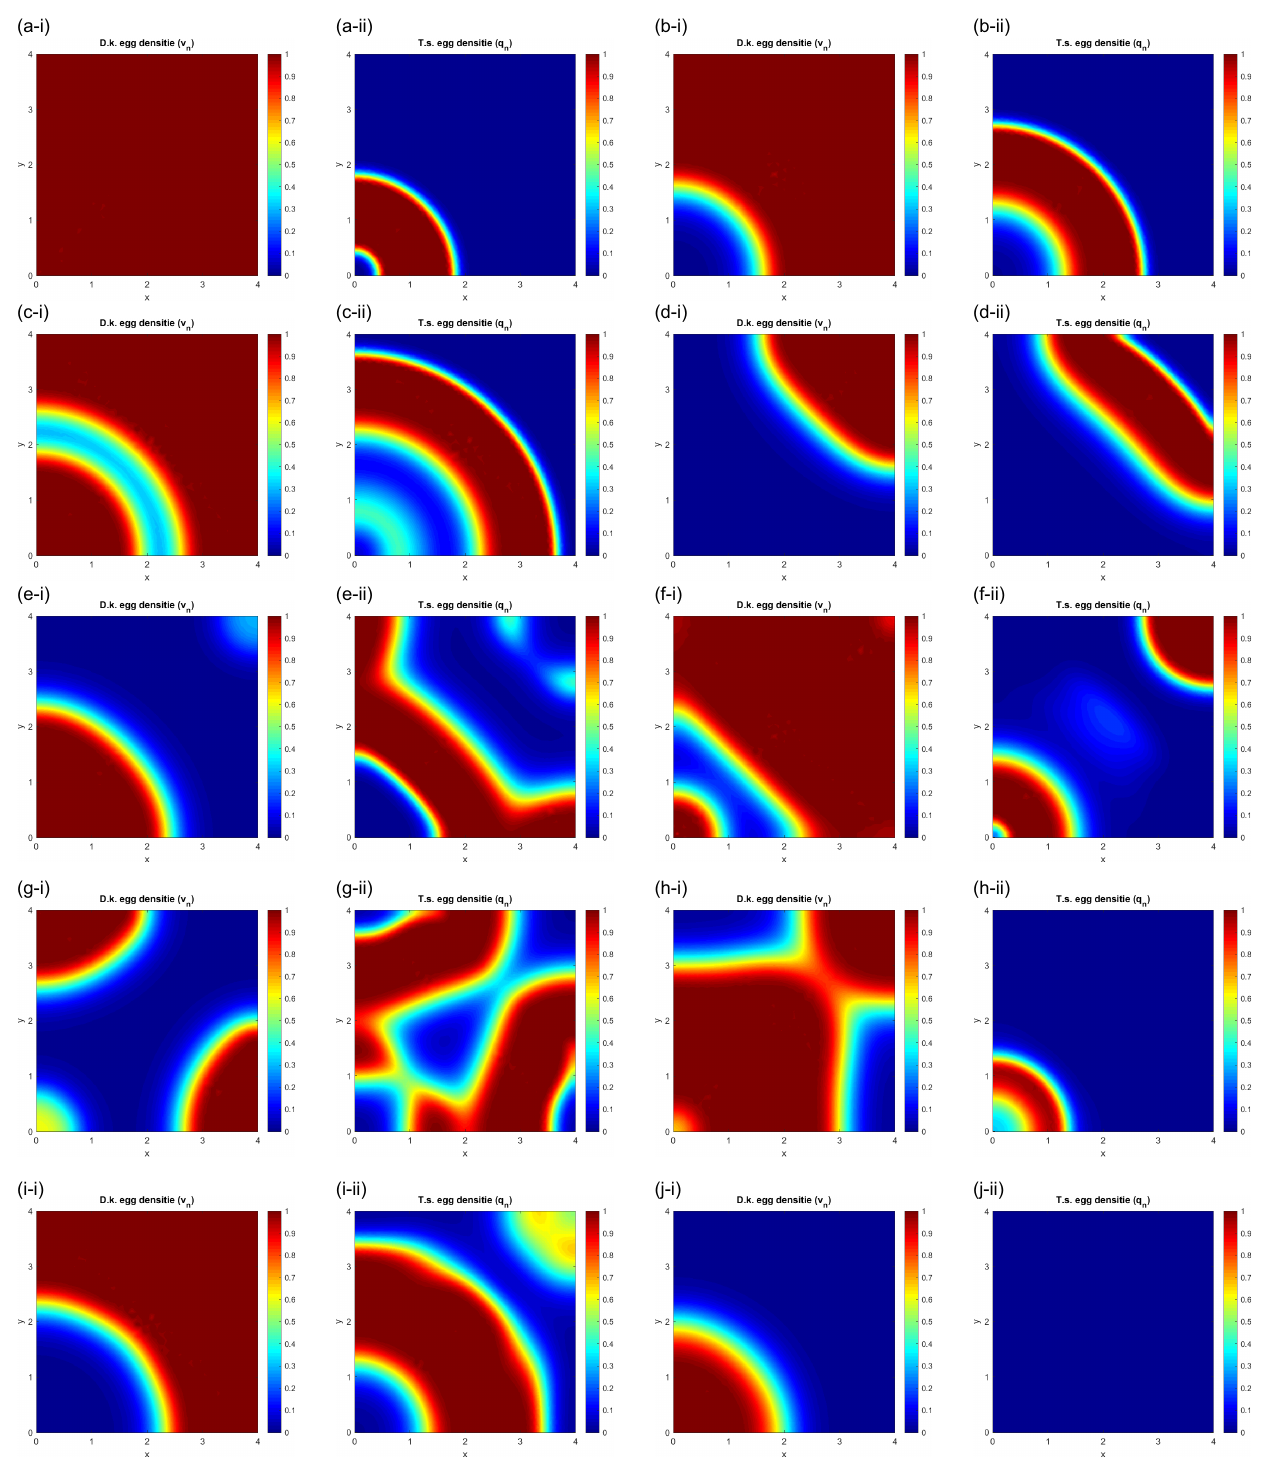
Fig 5. Spatial evolution of the D. kuriphilus and T. sinensis egg density over the years, in an area of 4 × 4 non-dimensional length units.